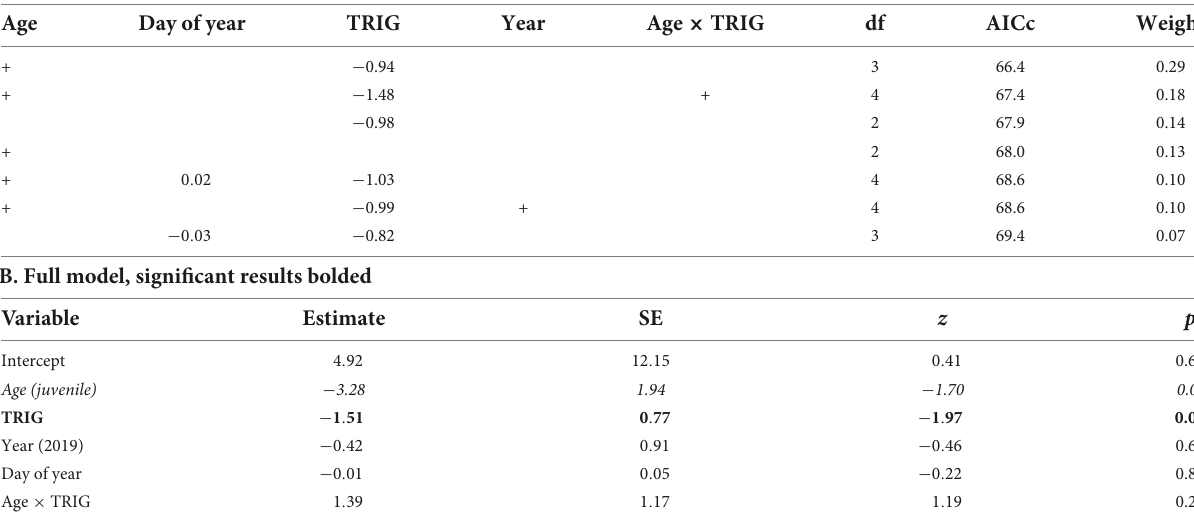
TABLE 5 AICc model selection (A) and full model output (B) of a binomial generalized linear model using data from birds tagged at Petit